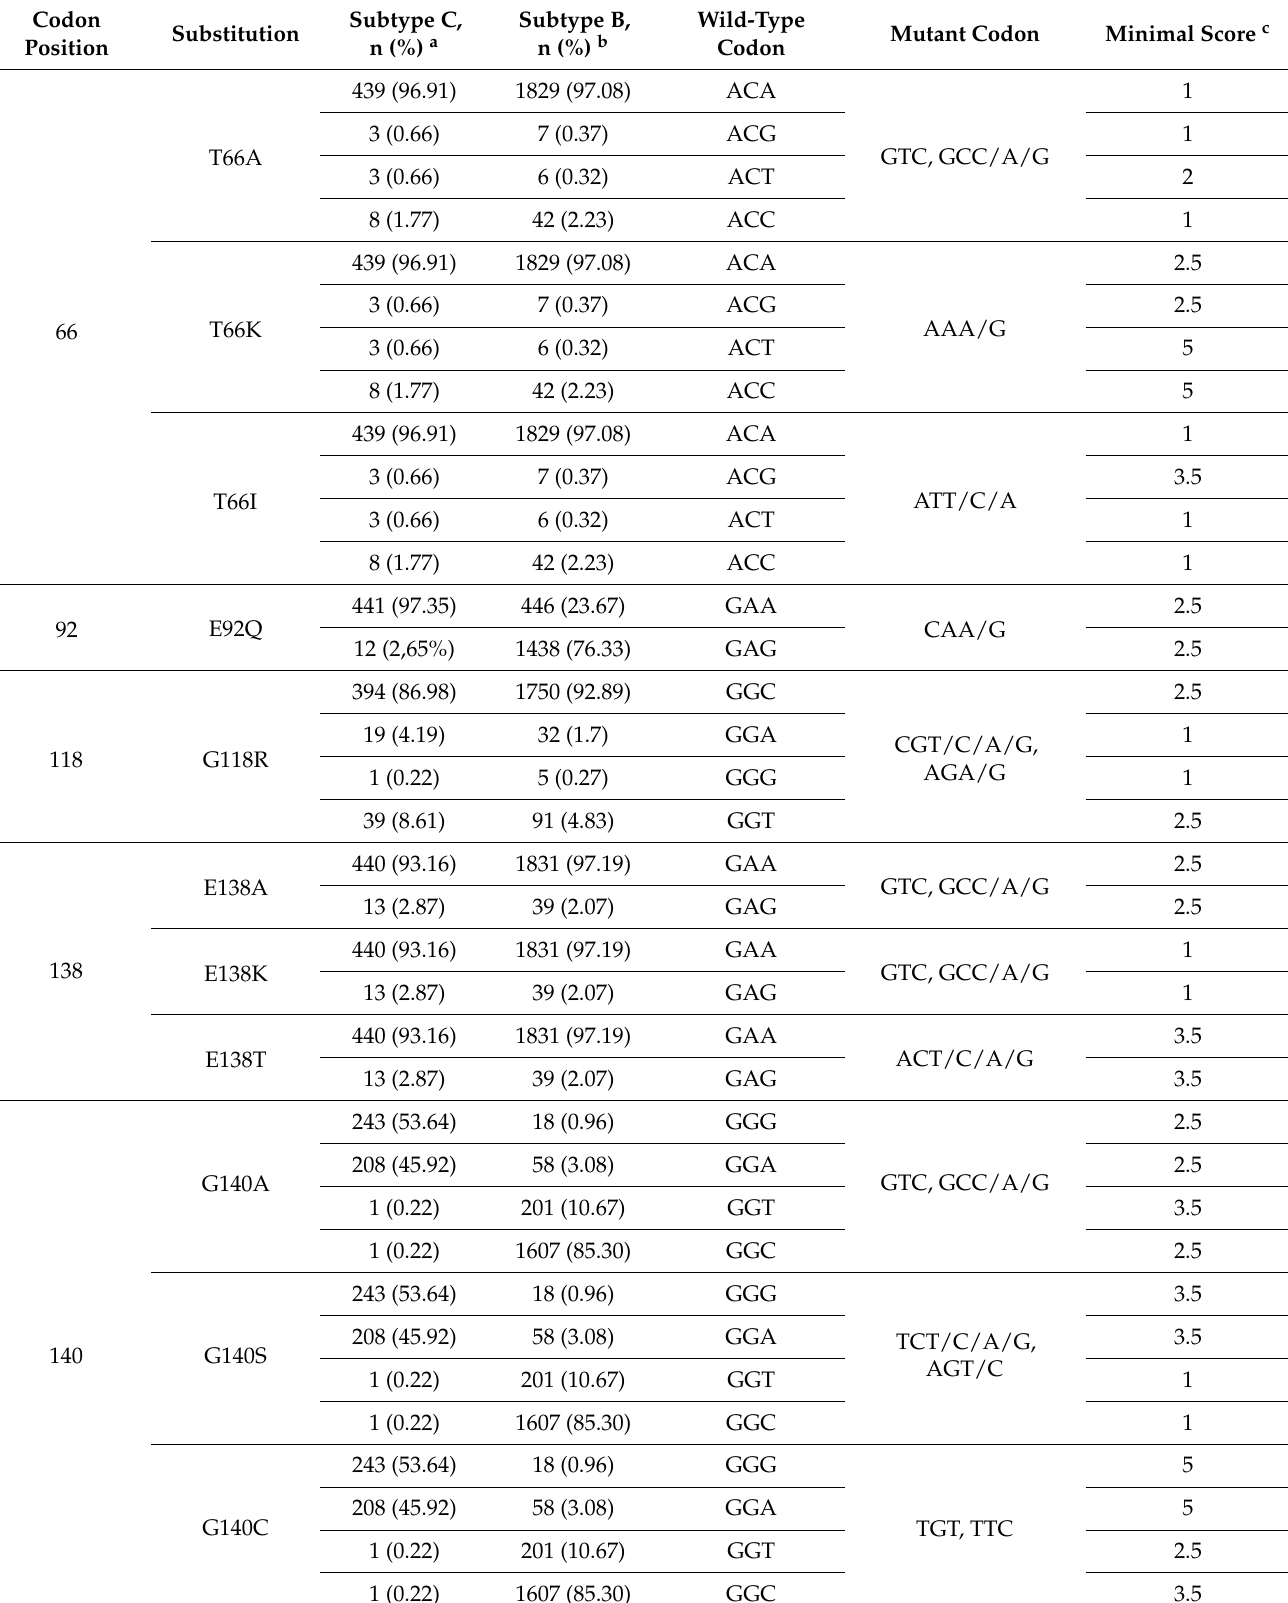
Table 2. Analysis of genetic barrier based on the minimum number of transitions and transversions required to obtain mutation resistance to